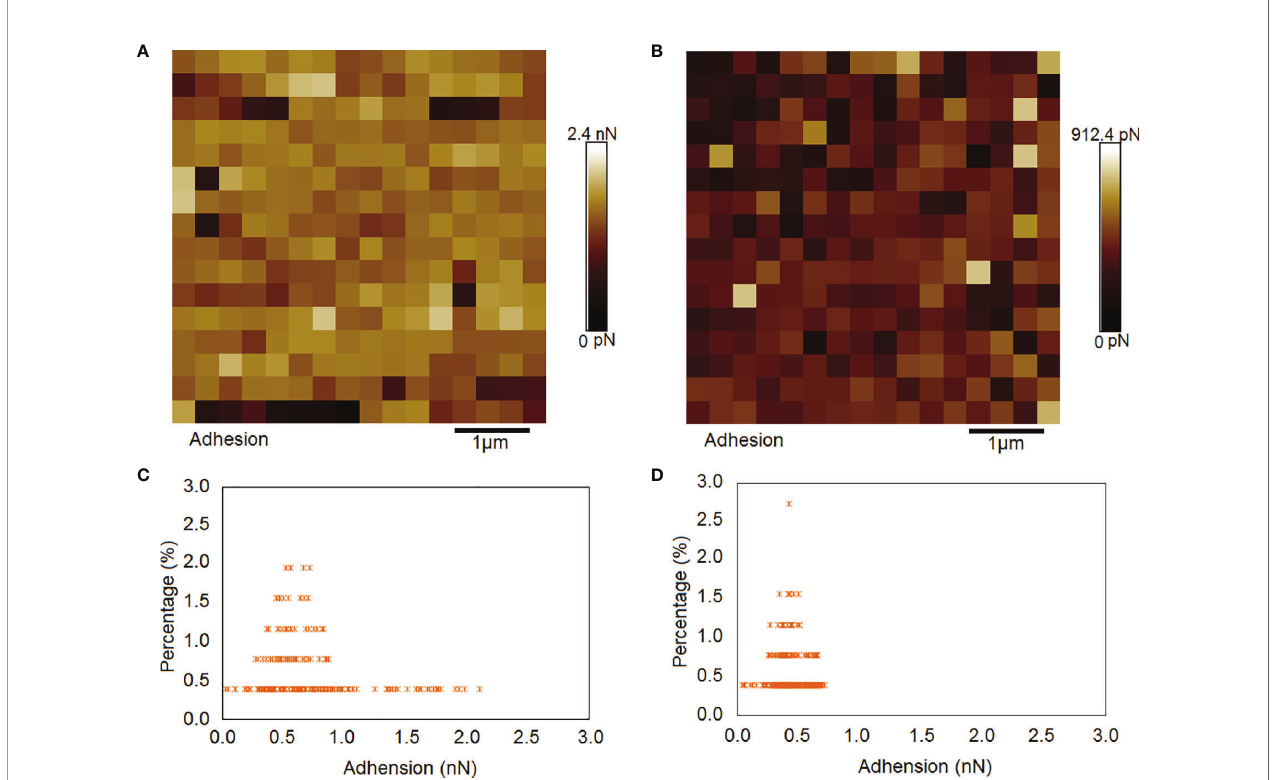
FIGURE 6 | Comparison of the cell surface adhesion of P. donghaiense. (A, C) The normal culture conditions. (B, D) The nitrogen limiting